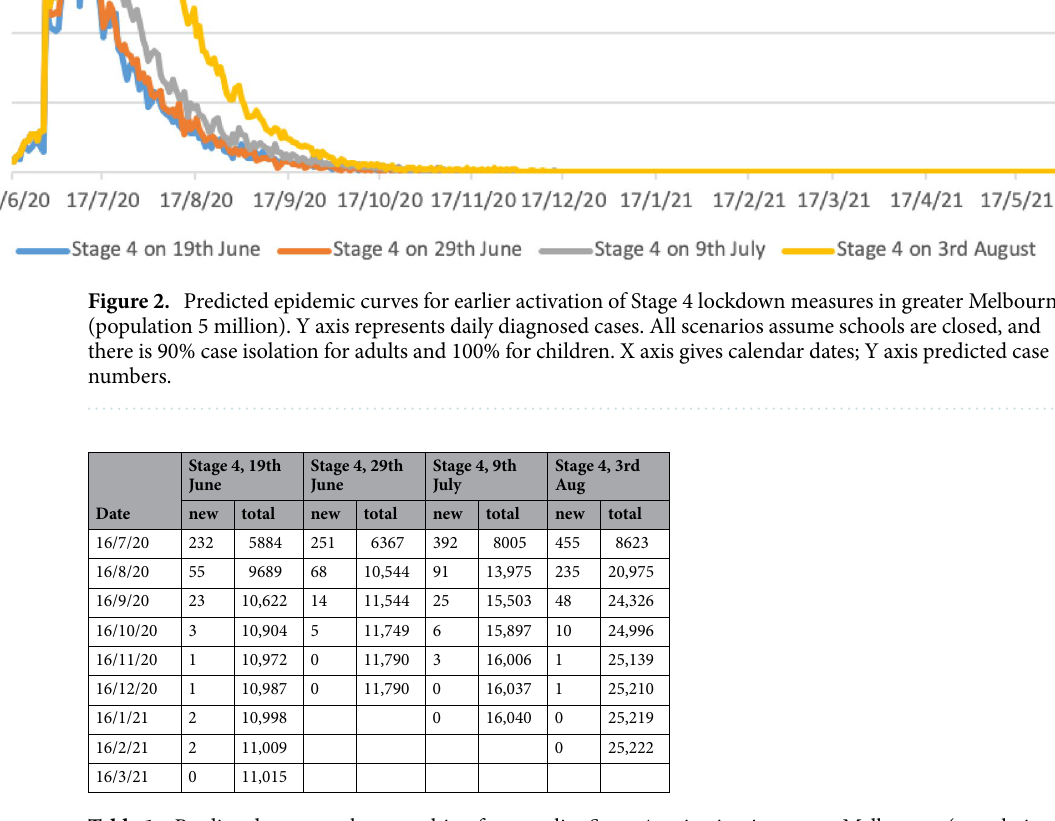
Table 1. Predicted case numbers resulting from earlier Stage 4 activation in greater Melbourne (population 5 million). All scenarios assume schools are closed, and 70% case isolation for adults and 100% for